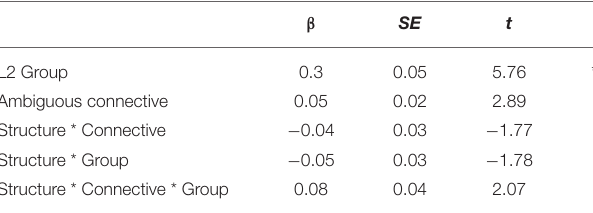
TABLE 10 | Model of both L1 + L2 data on segment 6 (Experiment